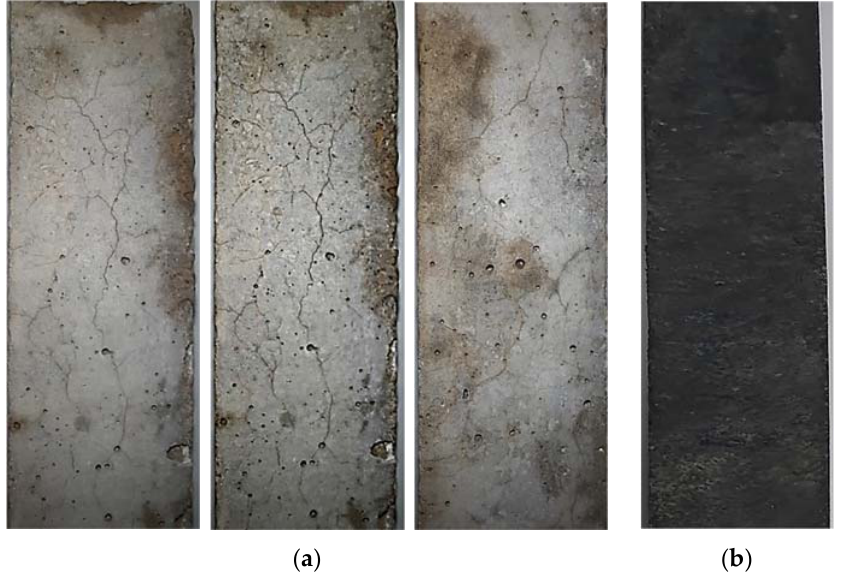
Figure 15. Surface cracks after exposure in ASR solution after 120 days. ( a ) Control specimens without RW; ( b ) Specimen with RW.